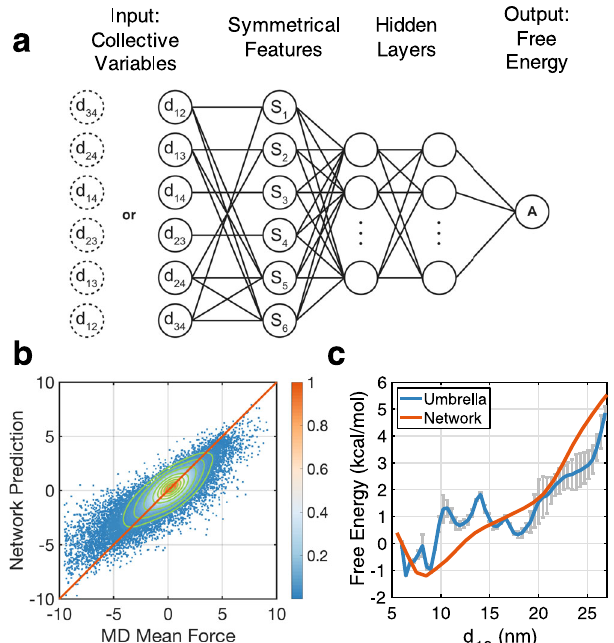
Fig. 3 Parameterization and validation of the six-dimensional free energy surface with a multilayer neural network. a Illustration of the neural network designed to take into account the symmetry of the structure with respect to index ordering. Input of this network is tetra-nucleosome con fi gurations represented via inter-nucleosomal distances and output is the corresponding free energy. b Comparison between mean forces in the unit of kcal/mol/nm determined from restrained molecular dynamics (MD) simulations and neural network prediction. The relative density of data points increases as the color changes from blue to white to red. The green lines are constant density contours and the red diagonal line is shown as a guide for the eye. c Comparison between the free energy pro fi le as a function of 1 – 3 nucleosome distance determined from neural network (orange) and umbrella sampling (blue). The error bars (grey shadow) represent one standard deviation from the